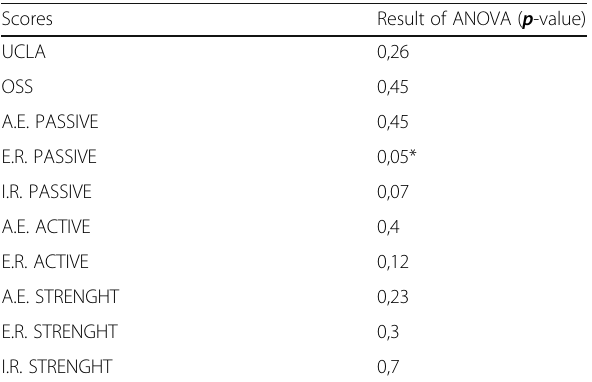
Table 3 Statistical comparison of clinical outcomes between the 3